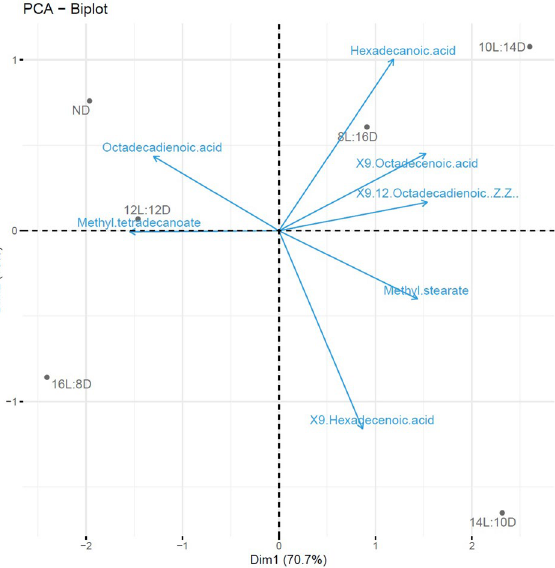
Figure 8. The PCA biplot projection of individual metabolites on the correlation circle in photoperiodic induced diapause metabolite composition for fatty acids in P. interpunctella